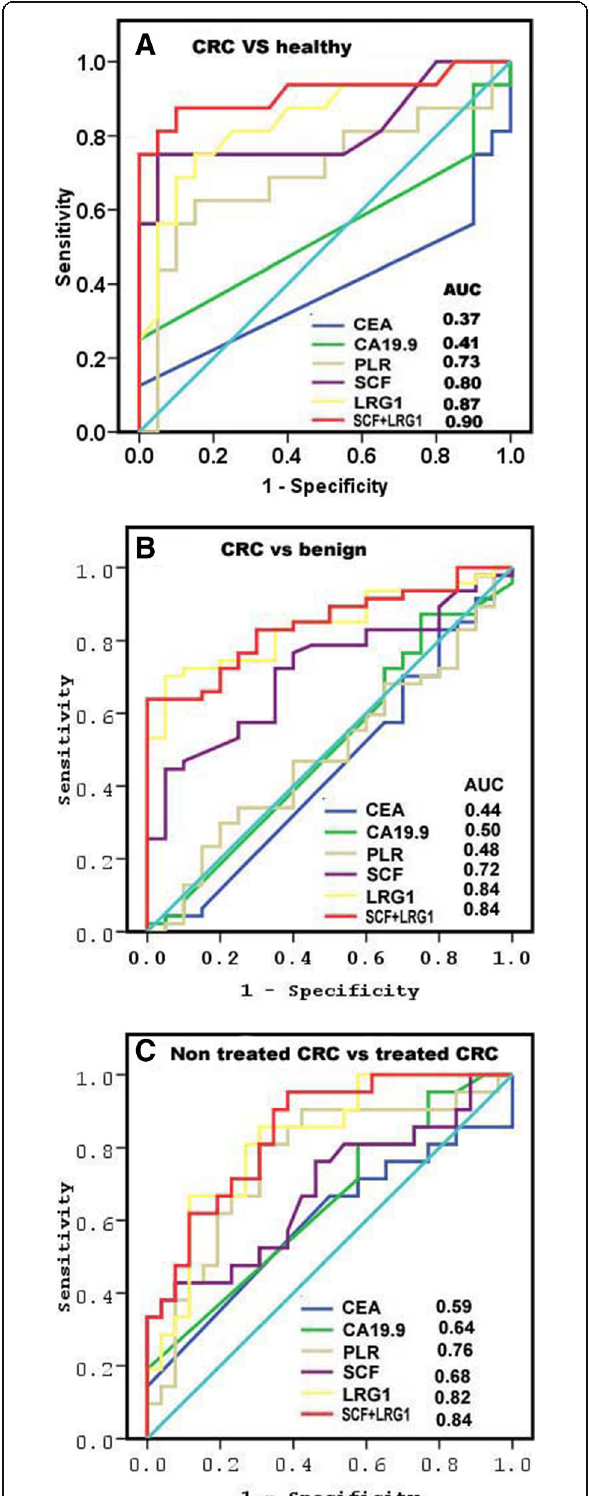
Fig. 1 Diagnostic power of single and combined markers. a CRC from healthy individuals. b CRC from benign. c Treated CRC from non-treated CRC